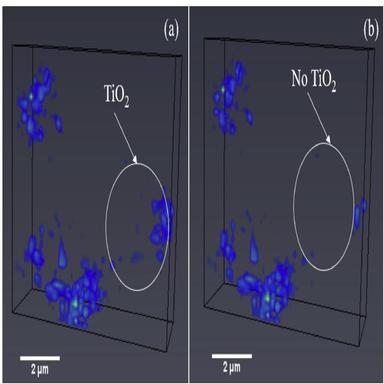
(a) 3D reconstructed images of the composite nanopaper and (b) targeting the distributions of Fe3O4 or TiO2 by dual-energy focal stacks imaging method based on STXM.